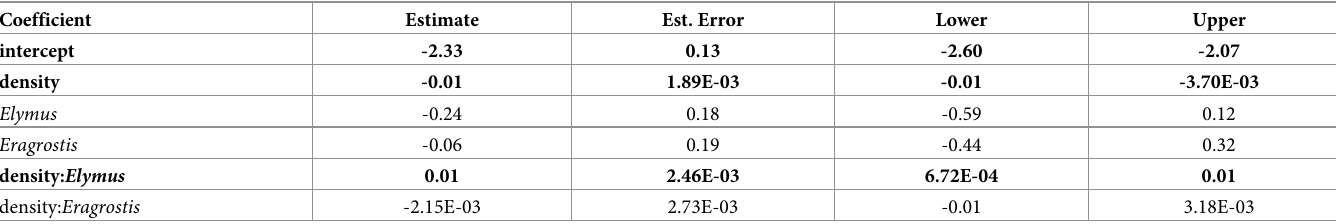
Table 1. Microstegium disease incidence model.